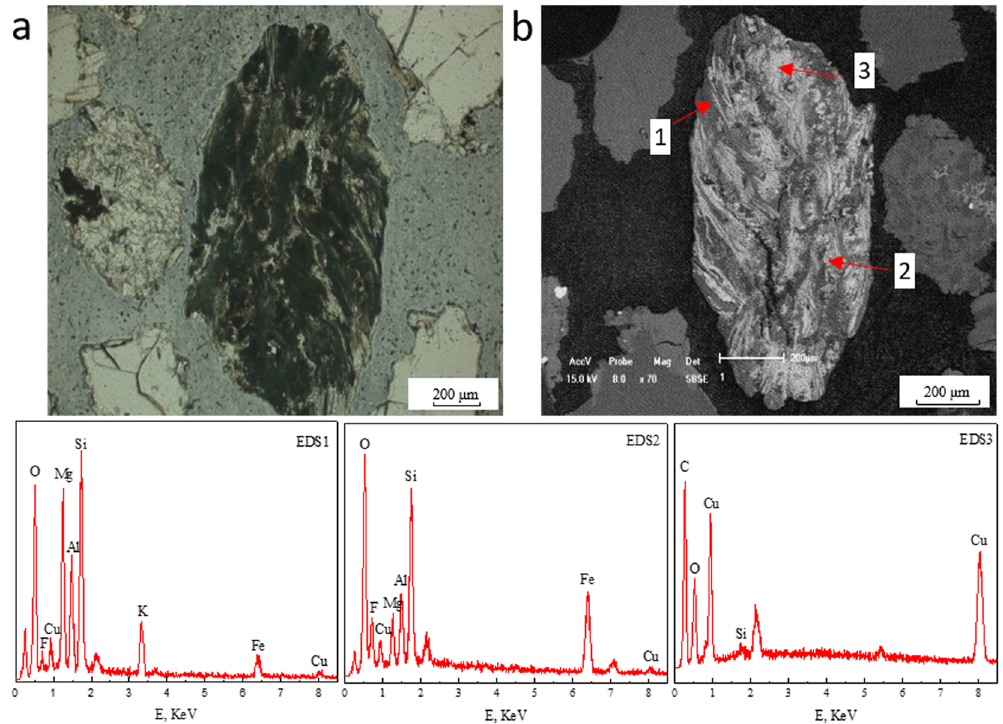
Figure 2. Planar polarizing microscopy and SEM-EDS diagrams of copper-bearing biotite altering into copper- bearing chlorite and malachite. ( a ) Planar polarizing microscopy. ( b ) SEM; EDS1, EDS2, EDS3. The spectra correspond to points 1, 2, 3 in SEM diagrams.